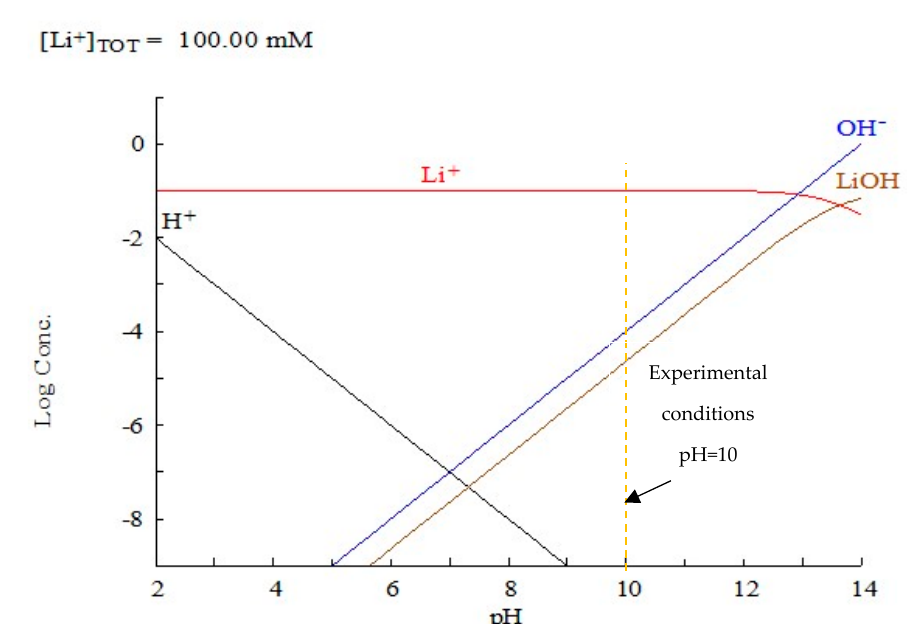
Figure 9. Logarithmic concentration Li + species distribution diagram as a function of pH for the system LiCl (0.1 M Li + ). Diagram was obtained using the HYDRA-MEDUSA numerical code.